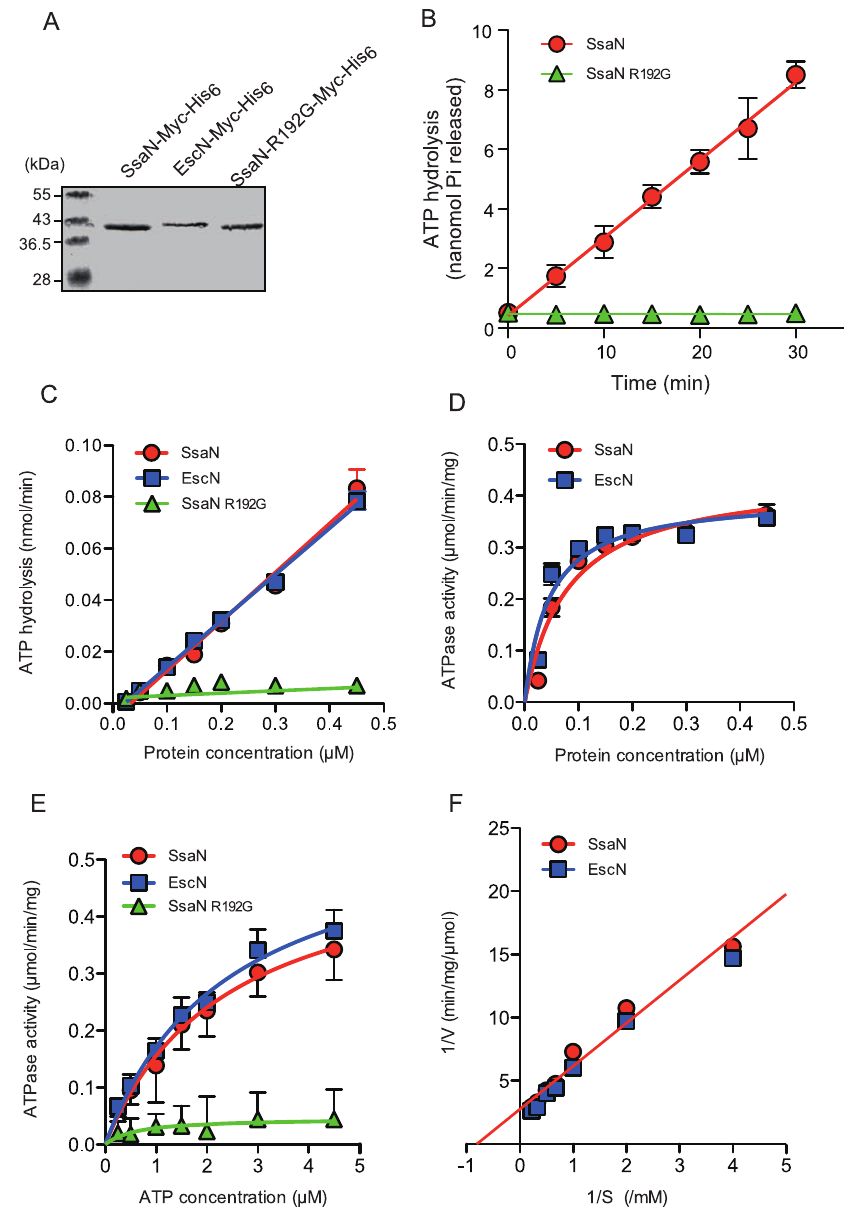
Figure 3. SsaN ATPase activity. ( A ) SsaN-Myc-His 6 , EscN-Myc-His 6 , and SsaN R192G -Myc-His 6 were purified by nickel affinity chromatography after elution with 500 mM imidazole. Proteins were analyzed by SDS–PAGE and stained with Coomassie brilliant blue. ( B ) ATP hydrolysis by purified SsaN- Myc-His 6 and SsaN R192G -Myc-His 6 fusion proteins was determined using a malachite green assay with 4 mM ATP in the presence of 4 mM MgCl 2 over a period of 30 min after adding the malachite green reagent. Error bars indicate standard deviations. ( C ) ATP hydrolysis with different concentration of SsaN-Myc-His 6 , EscN-Myc-His 6 , and SsaN R192G -Myc-His 6 fusion proteins. Error bars indicate standard deviations. ( D ) ATPase activity with different concentration of SsaN-Myc-His 6 and EscN-Myc-His 6 . Error bars indicate standard deviations. ( E ) ATPase activity of SsaN-Myc-His 6 , EscN-Myc-His 6 , and SsaN R192G -Myc-His 6 with ATP concentrations ranging from 1 to 5 mM. Error bars indicate standard deviations. ( F ) Data acquired in panel E were used to generate a Lineweaver–Burk plot. S: substrate, V: velocity of the enzymatic